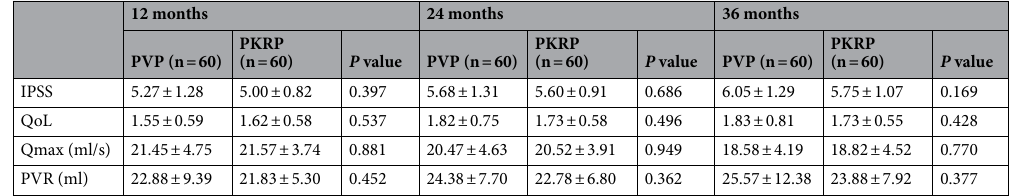
Table 2. 3-year follow-up results of PVP group and PKRP group. IPSS International Prostate Symptom score, QoL Quality of Life score, Qmax maximal urinary flow rate, PVR postvoid